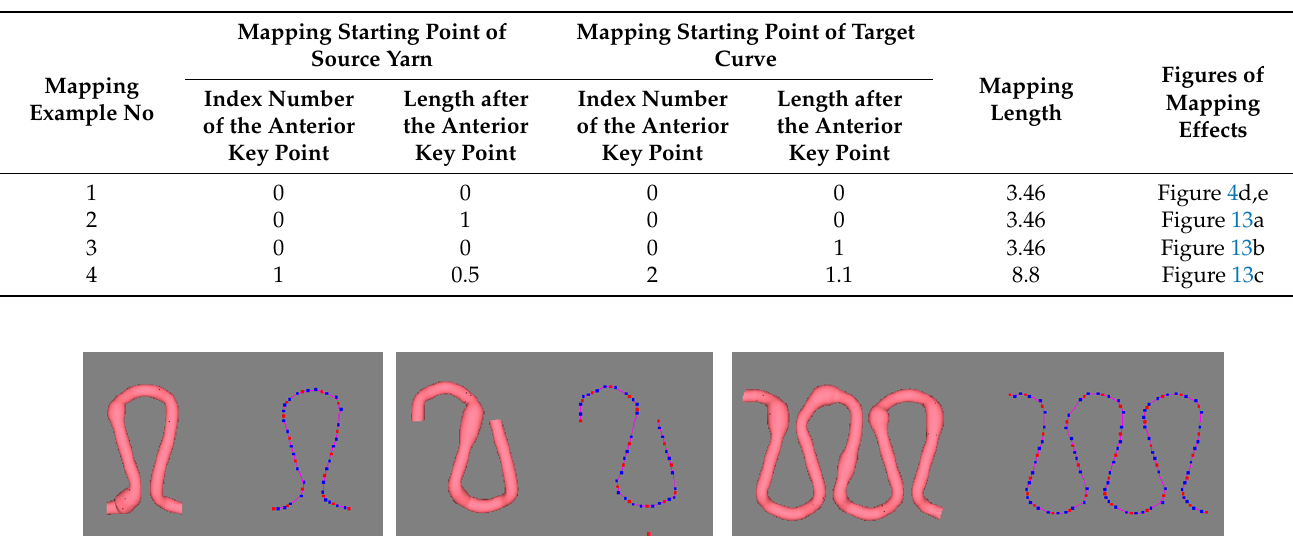
Figure 13. The mapping effect with different mapping starting points and mapping length. ( a ) Map- ping a full unit length of the source yarn at the origin of the target curve. ( b ) Mapping a full unit length from the origin of the source yarn onto the target curve. ( c ) Mapping a random length of a given position of the source yarn onto the target curve at another specified position.